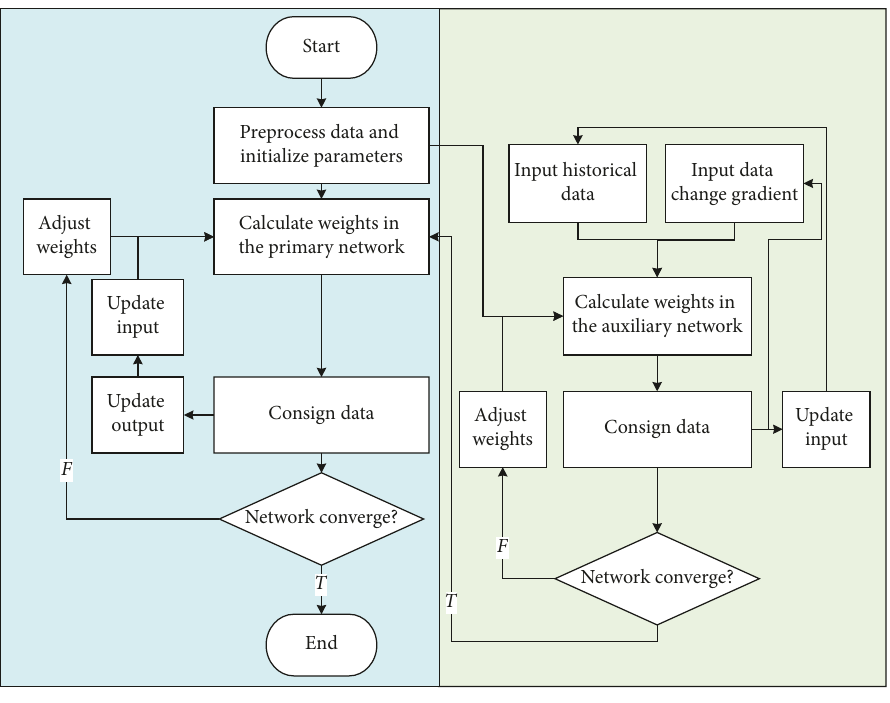
Figure 3: Prediction algorithm flow for the multivariate time series.